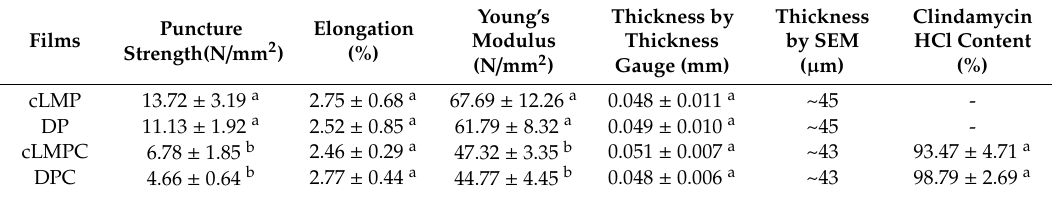
Table 5. The mechanical properties of the cLMP and DP films with and without clindamycin HCl.